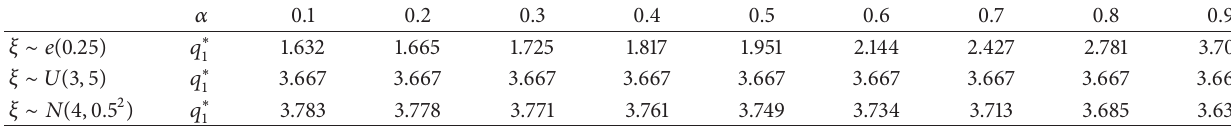
Table 1: Optimal wholesale prices for different distributions of 𝜉